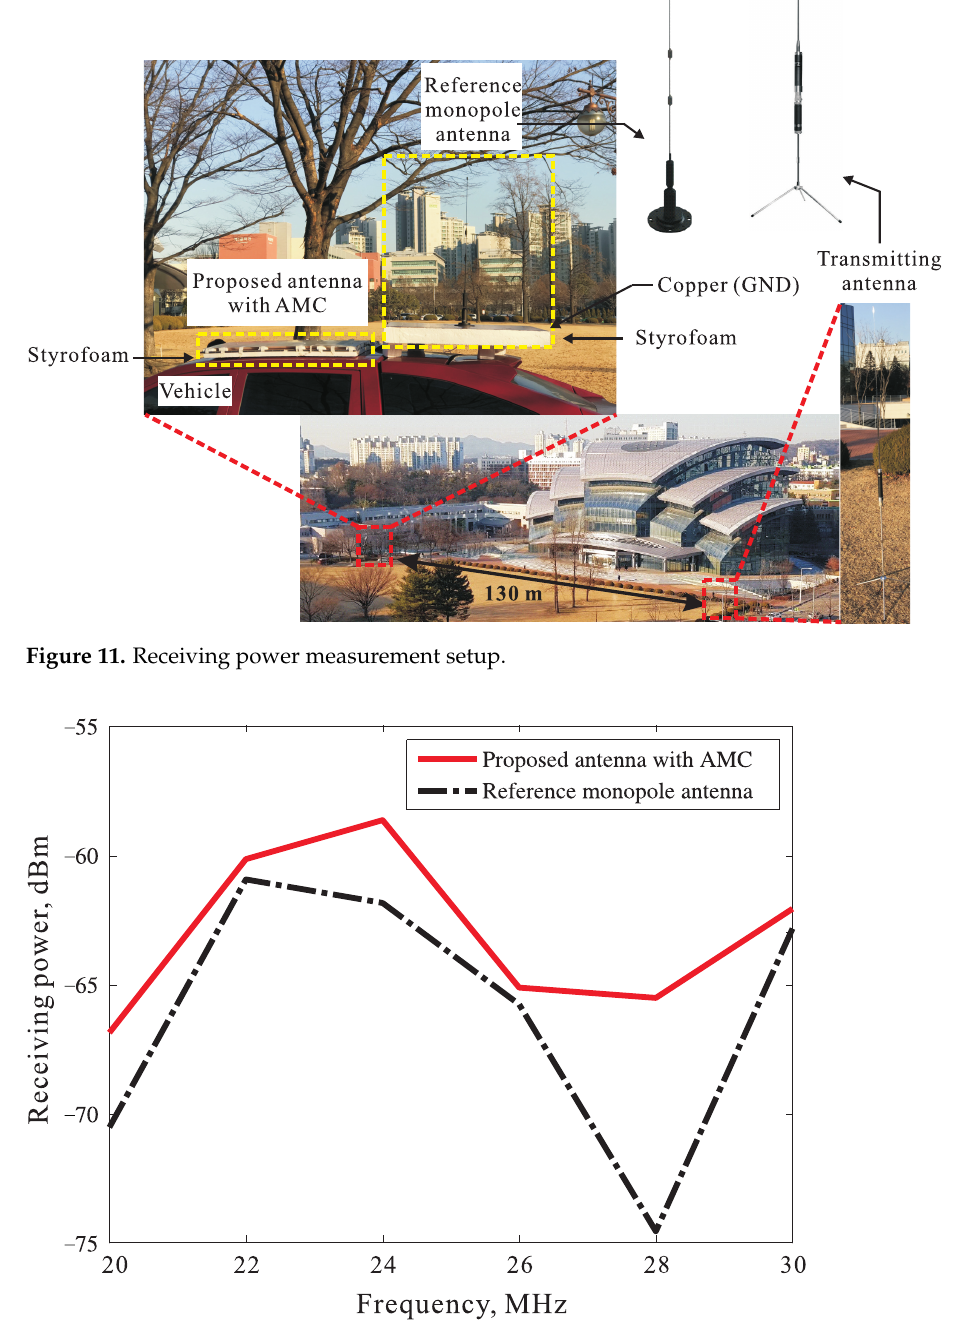
Figure 12. Measured receiving power levels of the proposed antenna with the AMC and the reference monopole